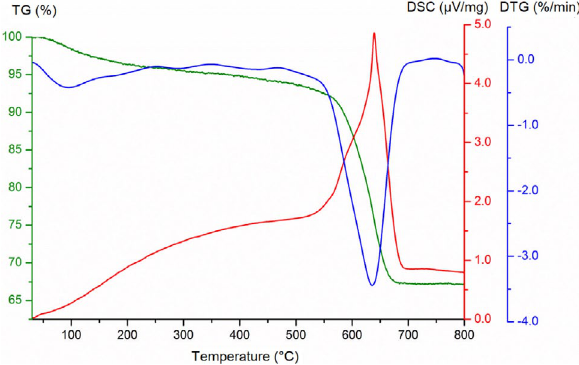
Fig. 1 TG, DTG, and DSC curves of the NiWO 4 precursor